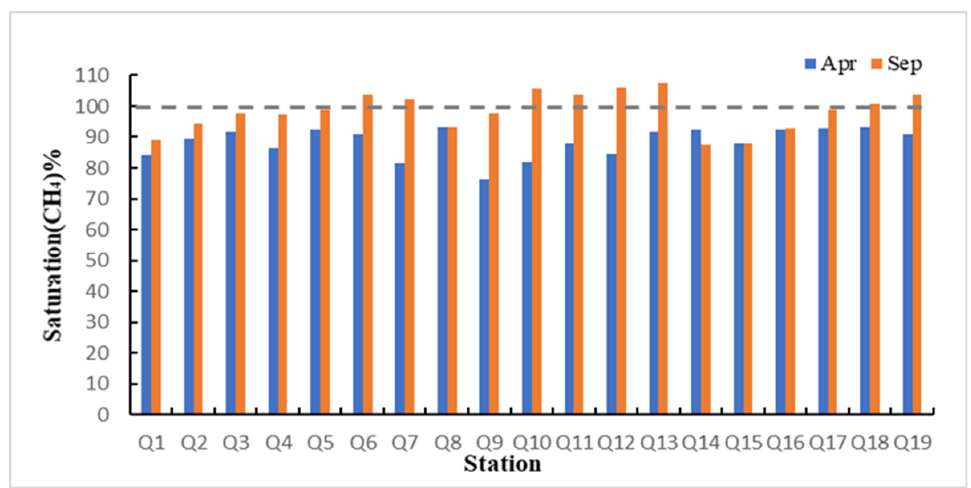
Figure 5. The saturation of methane in the surface water of each station in different seasons in the Qiongdongnan area. 3.2. Ship-Based Simultaneous Observation Relying on the National Gas hydrate special project of the China Geological Survey, the observation system was carried by the “Marine Geology No. 6” survey ship in June 2019 to conduct environmental baseline surveys in the Qiongdongnan area of the South China Sea. The survey ship and survey area are shown in Figures 6 and 7. A PIcarro